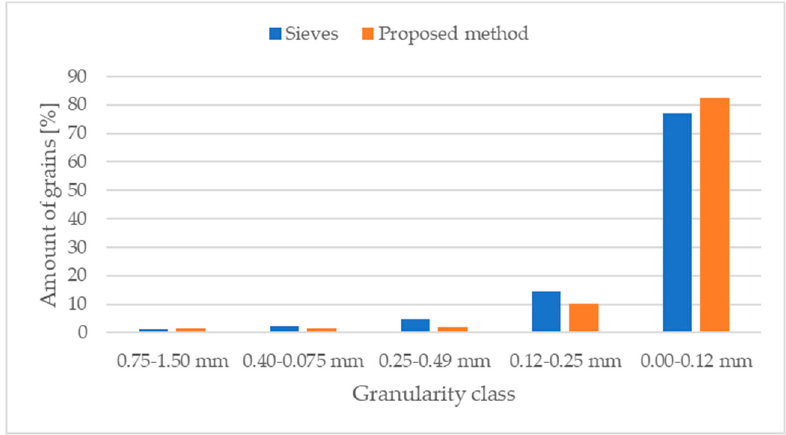
Figure 14. The comparison of total amount of grains [%] in the proposed and reference methods.